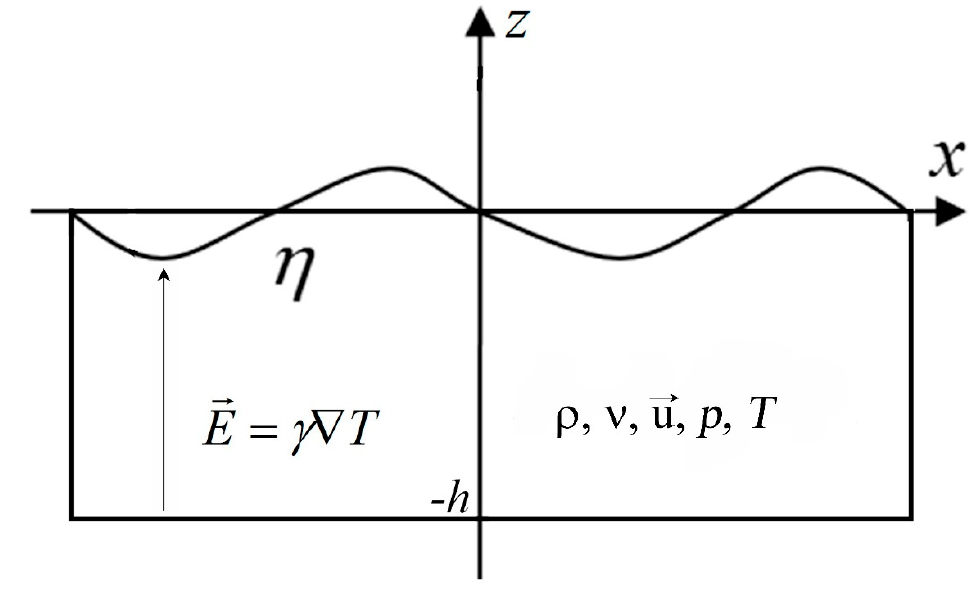
Figure 2. Scheme of combination instability formation.